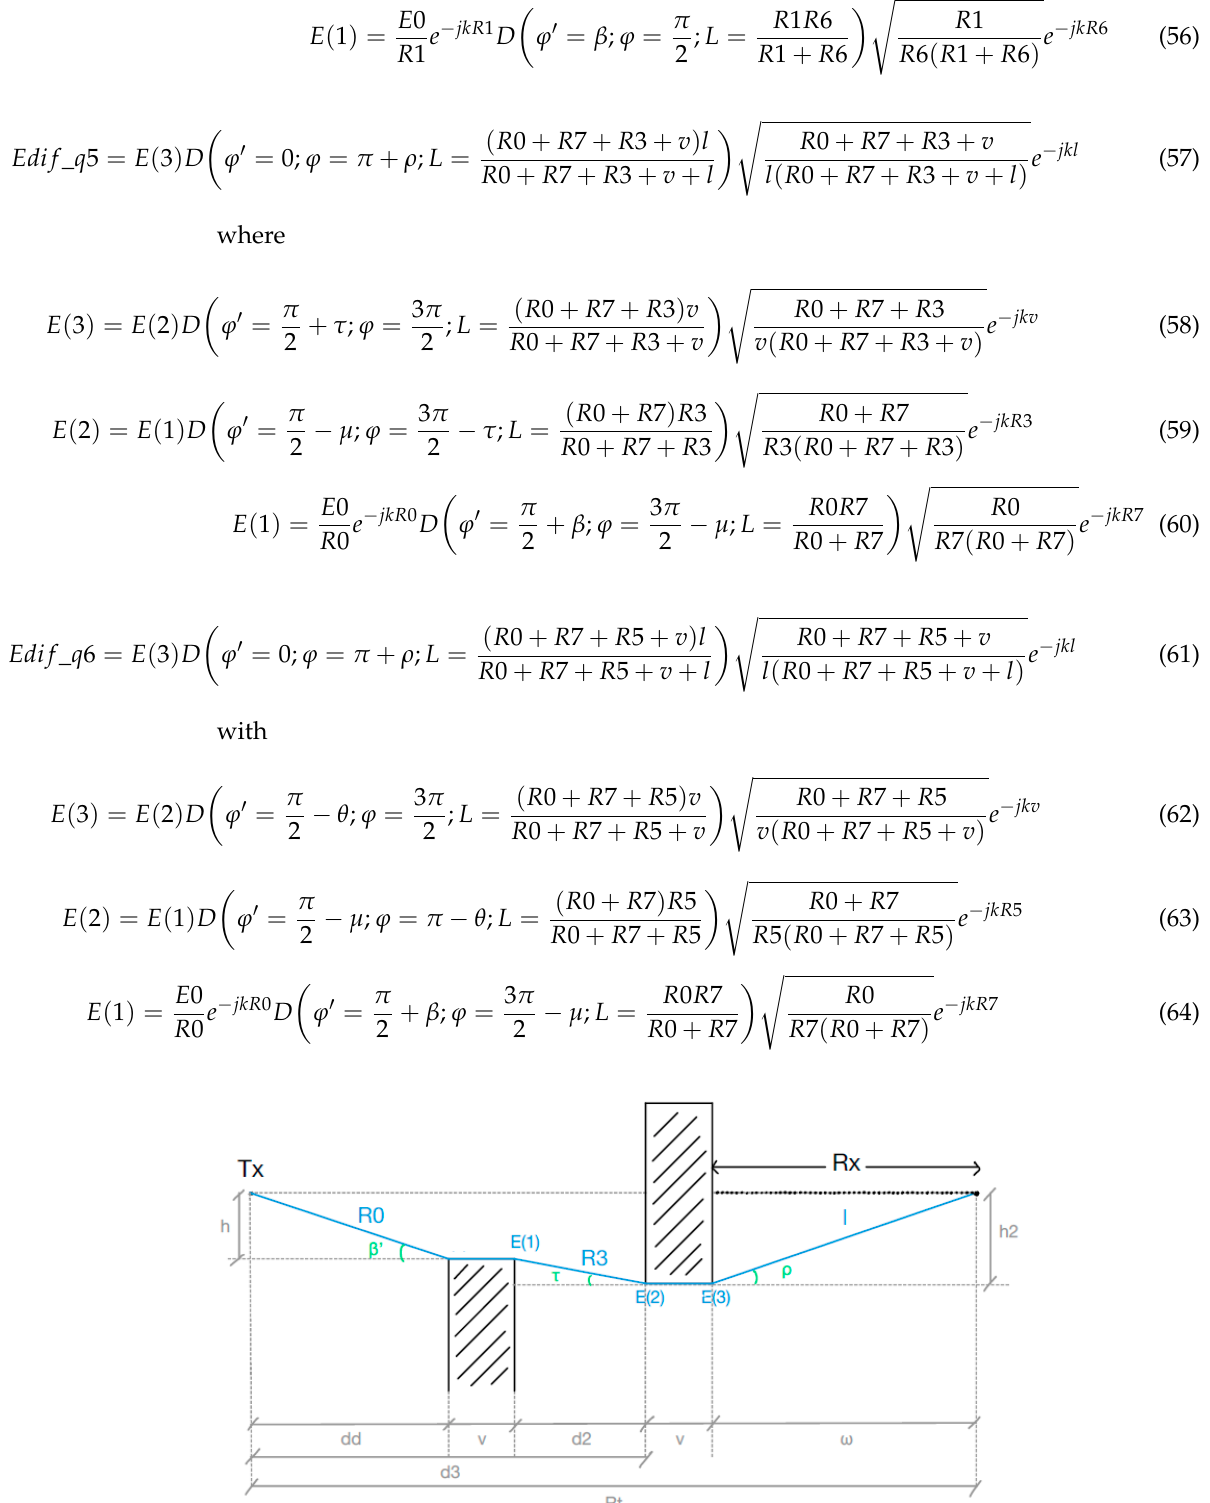
Figure 22. First quadruple diffraction (Edif_q1) of the second considered NLOS scenario.